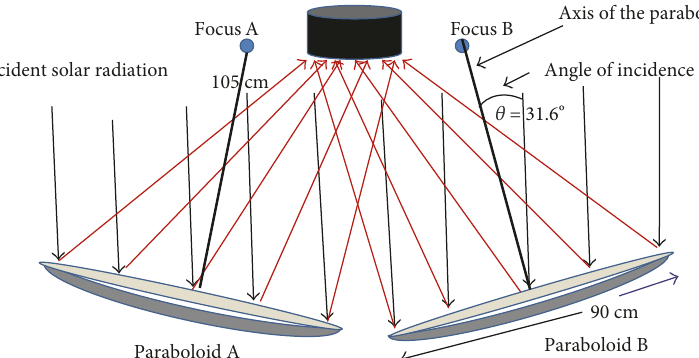
Figure 1: Optical scheme of the light re fl ected from a dual paraboloid re fl ecting system de fi ning a dispersed